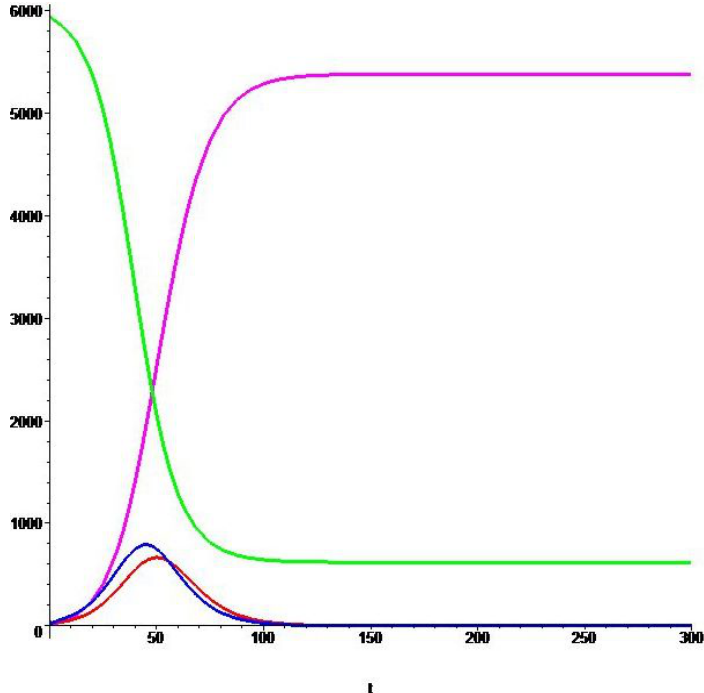
( t ) , E ( t ) , I ( t ) , R ( t ) for the Ebola outbreak ∗ ∗ ∗ ∗